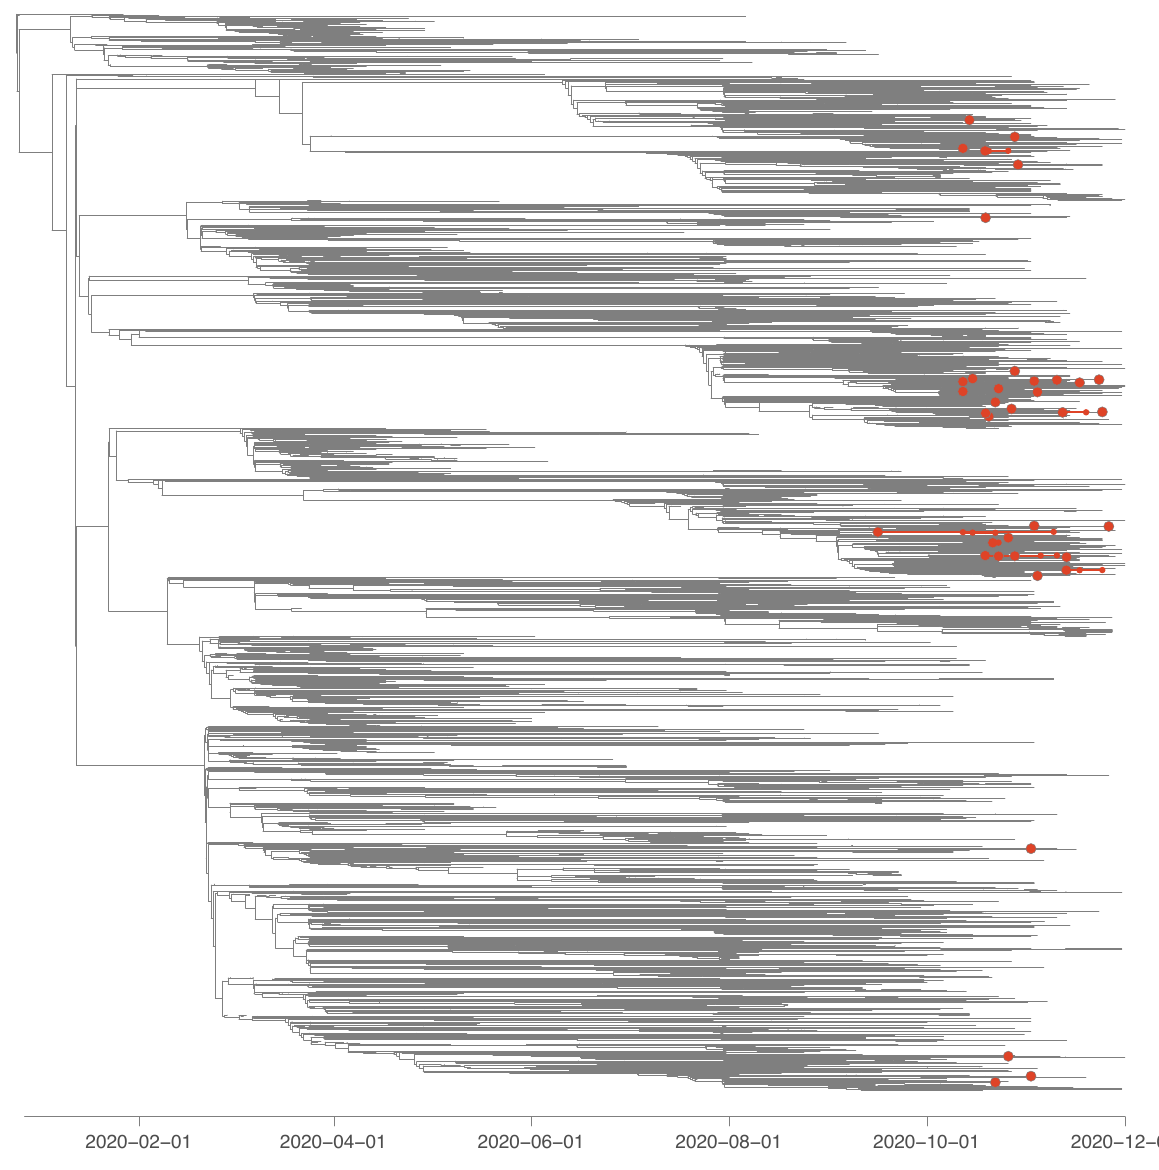
Figure 4. Time-scaled phylogeny in which we identified phylogenetic clades introduced in the University Hospital of Li è ge (Belgium) and delineated through a discrete phylogeographic recon- struction along the tree (while only considering two potential ancestral locations: “hospital” and “other location”). We identified a minimum of 35 introduction events into the hospital (95% highest posterior density interval = [36–38]) for 45 sequences sampled among healthcare workers (HCWs) from the hospital. On the phylogeny, large red nodes correspond to the most ancestral node of each clade resulting from an introduction event into the hospital. Most of these clades consist of only one sampled sequence: 30 (95% highest posterior density interval = [27–32]) out of 45 sequenced positive cases corresponded to independent introduction events into the hospital. In the figure, small red nodes correspond to sampled sequences that would not result from a distinct introduction event into the hospital. In other words, smaller red nodes are tip nodes belonging to clades gathering at least two sequences sampled among HCWs from the hospital. In the figure, smaller red nodes are tip nodes corresponding to sequences sampled among HCWs but that do not result from a distinct introduction event into the hospital. In other words, smaller red nodes correspond to clades gathering at least two sequences sampled among HCWs, and the phylogenetic branches of these clades are also highlighted in red. See Figure S1 for an alternative circular visualization of this annotated phylogenetic